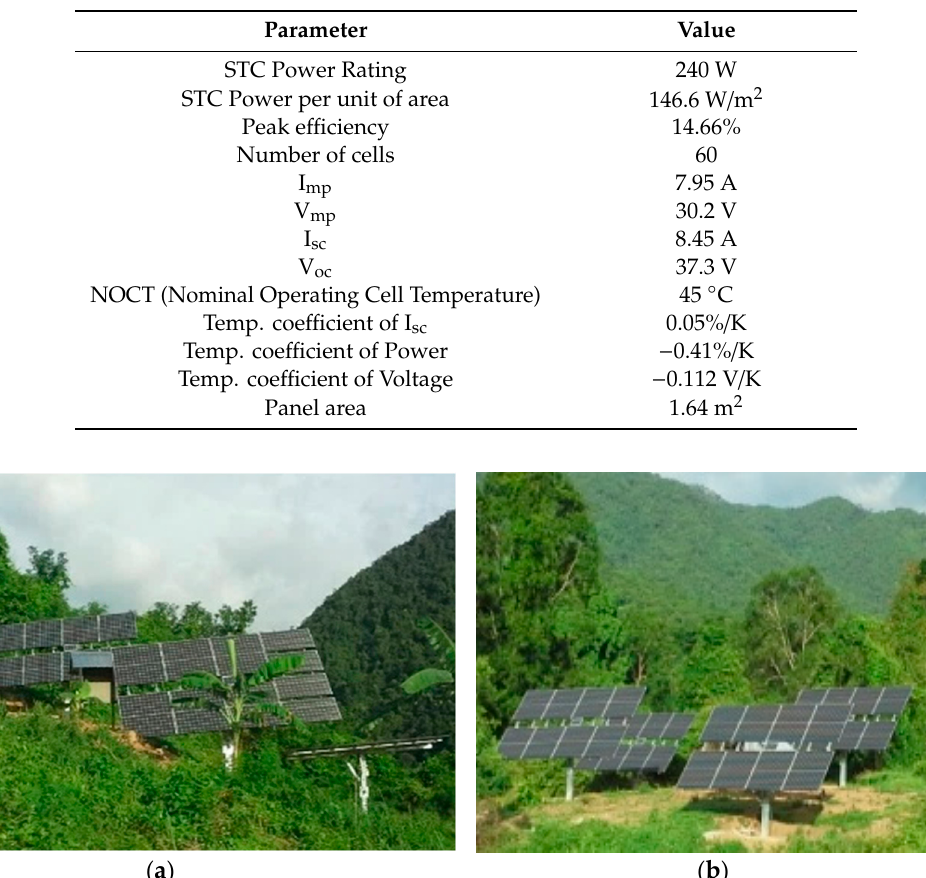
Table 3. Characteristics of the monocrystalline silicon PV panel JKM240M-60 (240 W).